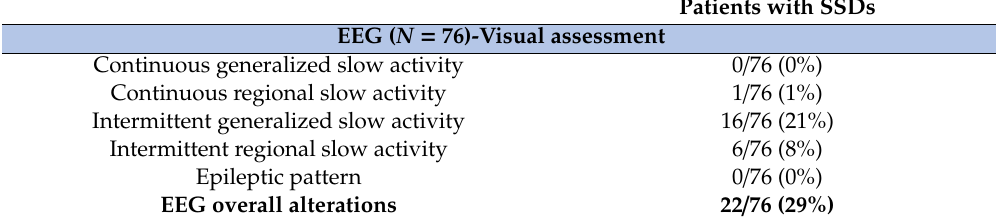
Table 8. Electroencephalography (EEG) and cerebral magnetic resonance imaging (cMRI) alterations in patients with schizophrenia spectrum disorders (SSDs). * Two patients had white matter lesions compatible with chronic inflammatory changes. One patient had multiple sclerosis-typical MRI lesions. This patient su ff ered from an isolated psychotic episode. She was diagnosed with multiple sclerosis in the past; however, the patient was not given prophylaxis against relapse. ** Two patients were only suspected of having a pineal cyst. Abbreviation: IRDA / IRTA, intermittent generalized rhythmic delta / theta activity; HV,